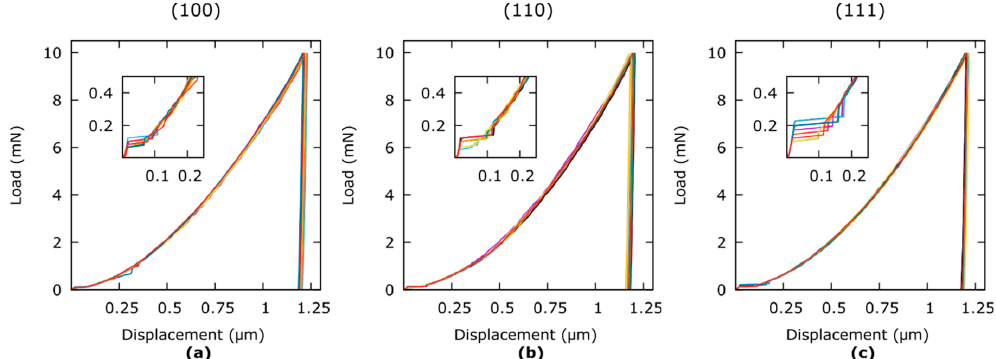
Figure 5. Indentation curves produced with the 6 × 6 arrays on differently oriented Al single crystal surfaces: ( a ) (100) orientation, ( b ) (110) orientation, and ( c ) (111) orientation. Average H IT values for particular crystallographic orientations are demonstrated in Figure 6.